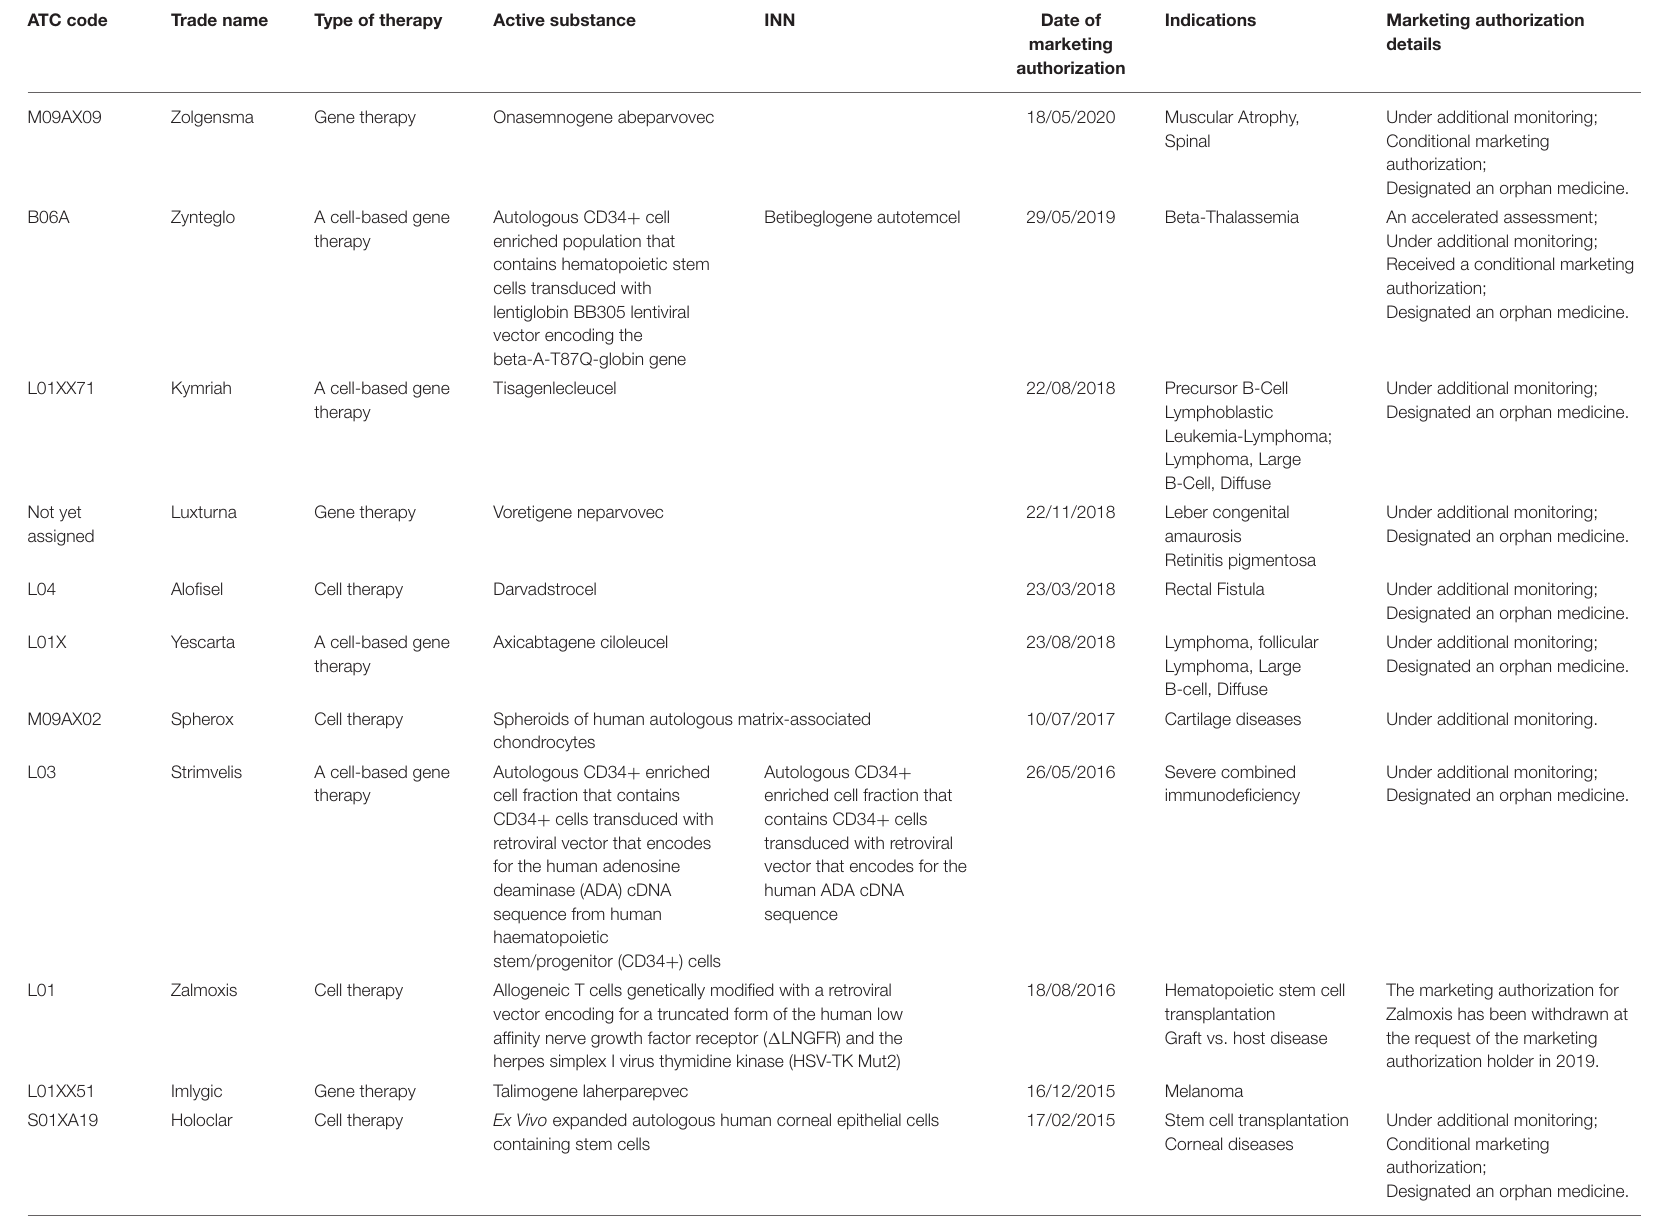
TABLE 2 | Advanced therapies authorized in the European Union (35,